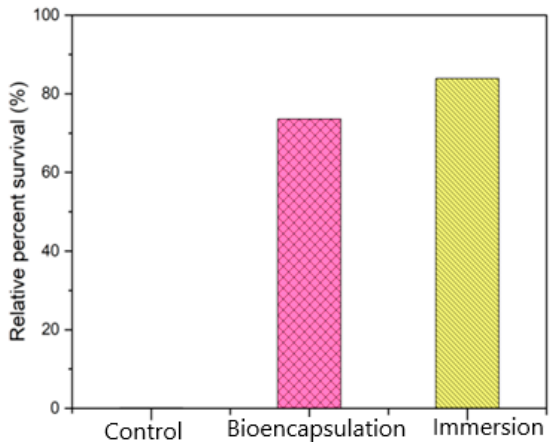
Figure 14. Relative Percent Survival (RPS) of all three groups (Control, Immersion & Bio-encapsu- lation)